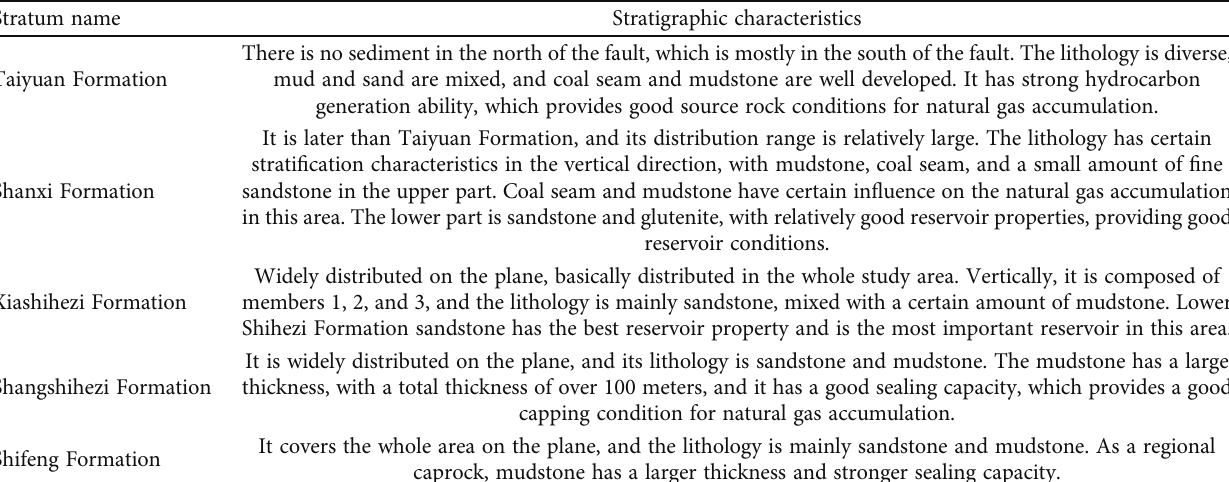
Table 1: Characteristics of various strata in Hangjinqi